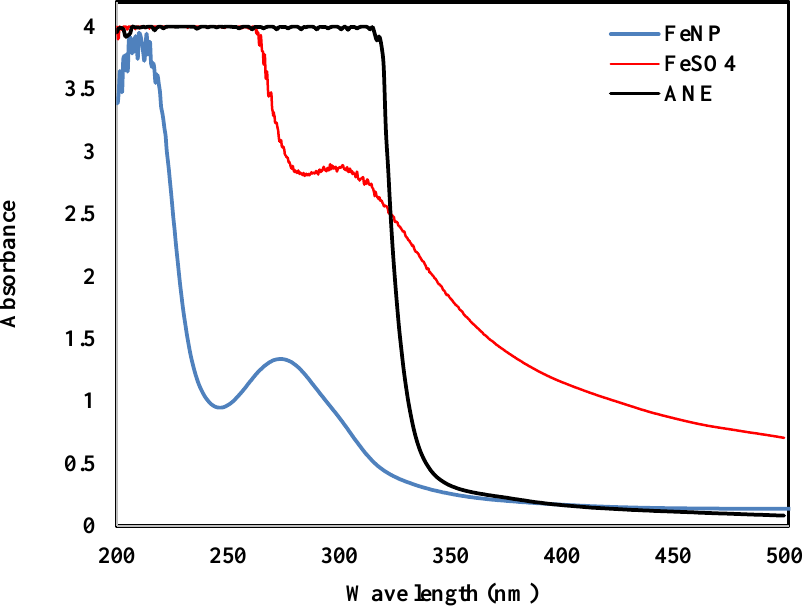
Figure 2. UV-Vis spectrum of iron nanoparticles (FeNP), ANE, and FeSO 4 .